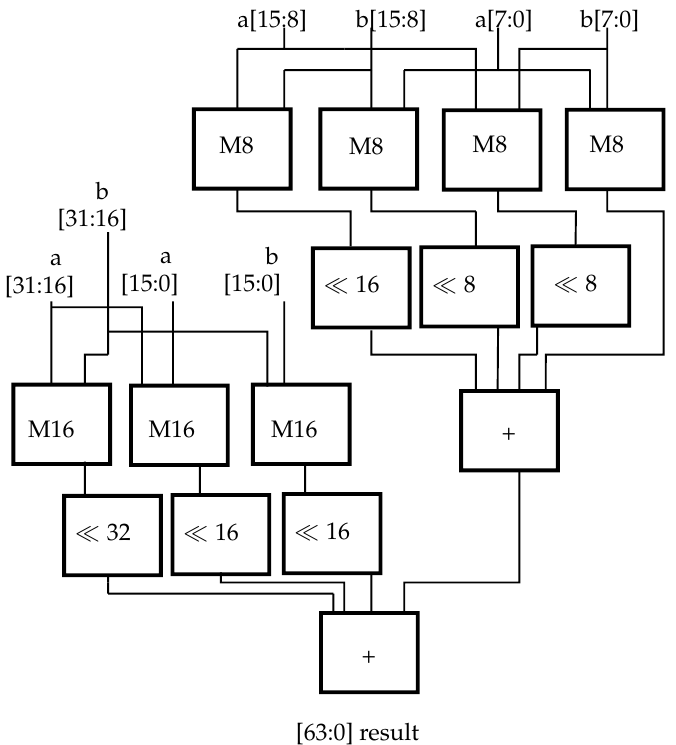
Figure 6. Combining the multipliers from 8- and 16-bit SIMD (M8, M16) together with an additional 16-bit multiplier to achieve a 32-bit multiplication in the 64-bit result. The result is then saved in two 32-bit write operations.